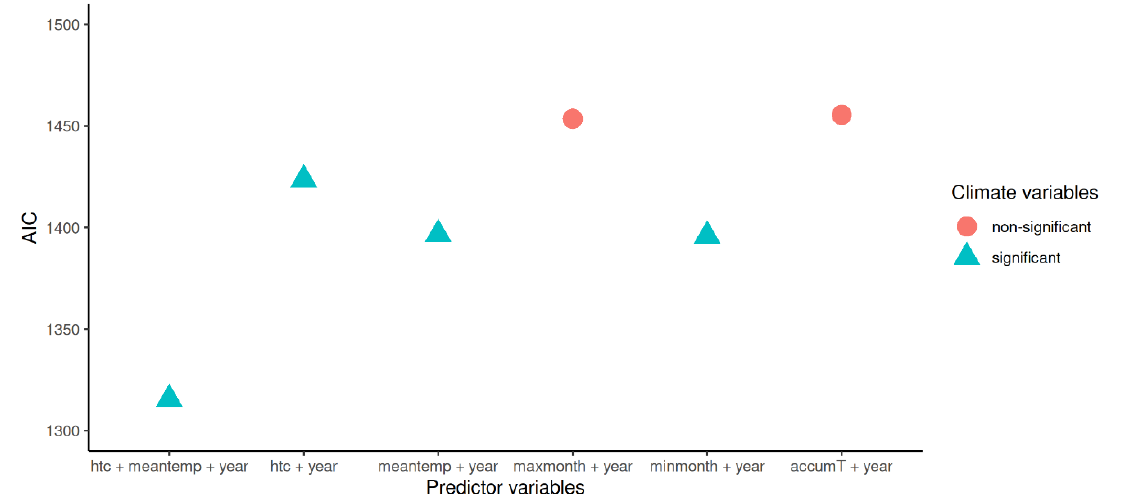
Figure 6. Comparison between negative binomial models with different combinations of predictor variables (on x -axis), and number of tick bite cases as a response variable. The y -axis shows the model fit (Akaike’s Information Criterion). Red circles indicate models where the climate variables were non-significant. Table 2. Estimates and confidence interval for predictor variables in negative binomial regression model with number of tick bite cases as response variable. All included parameters are significant at p < 0.01. All values are exponentiated to reflect true response.